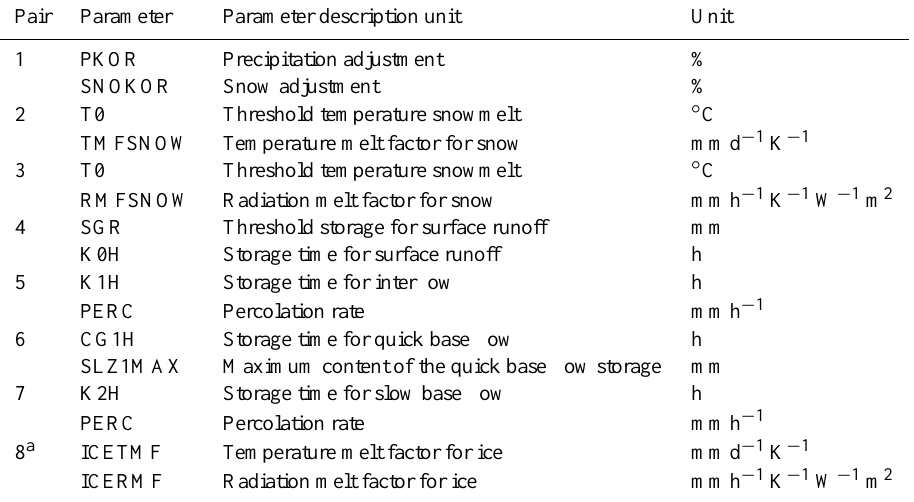
Table 1. Grouping of parameters for successive pair-wise calibration of PREVAH (Viviroli et al., 2009b). Pair